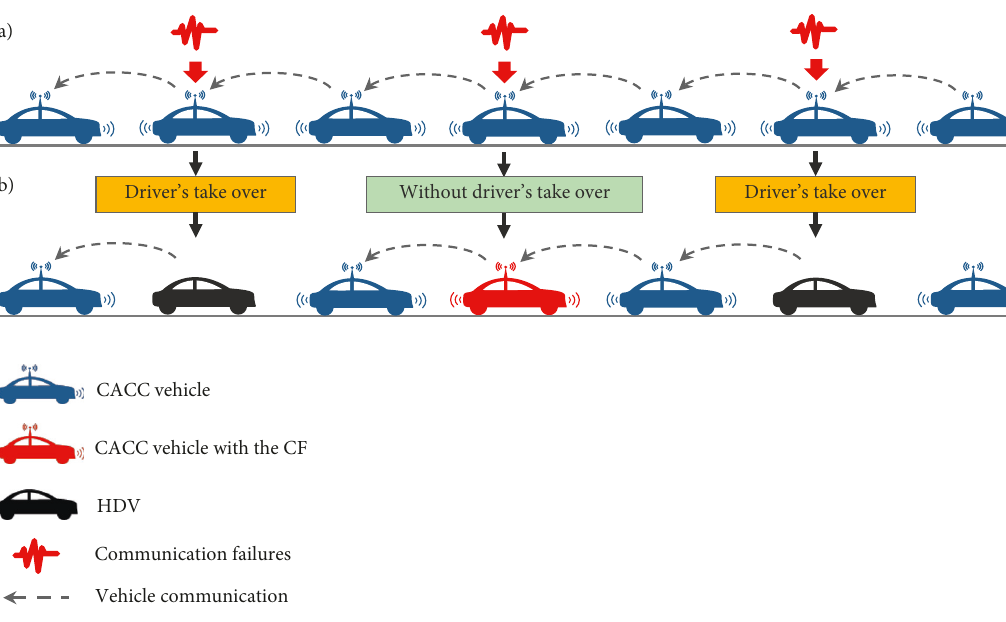
Figure 1: The illustration of traffic flow